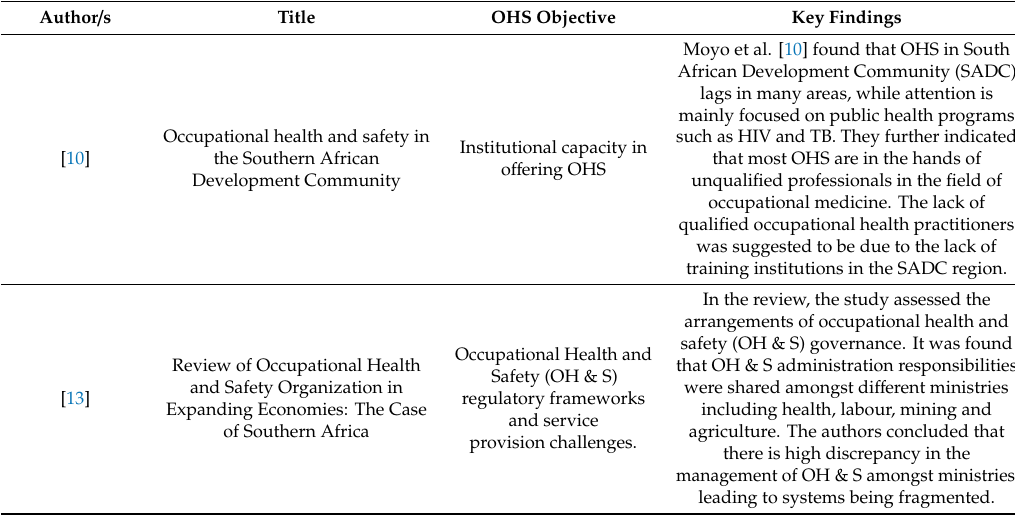
Table 1. Results of literature review on occupational health services’ (OHS) legislation and